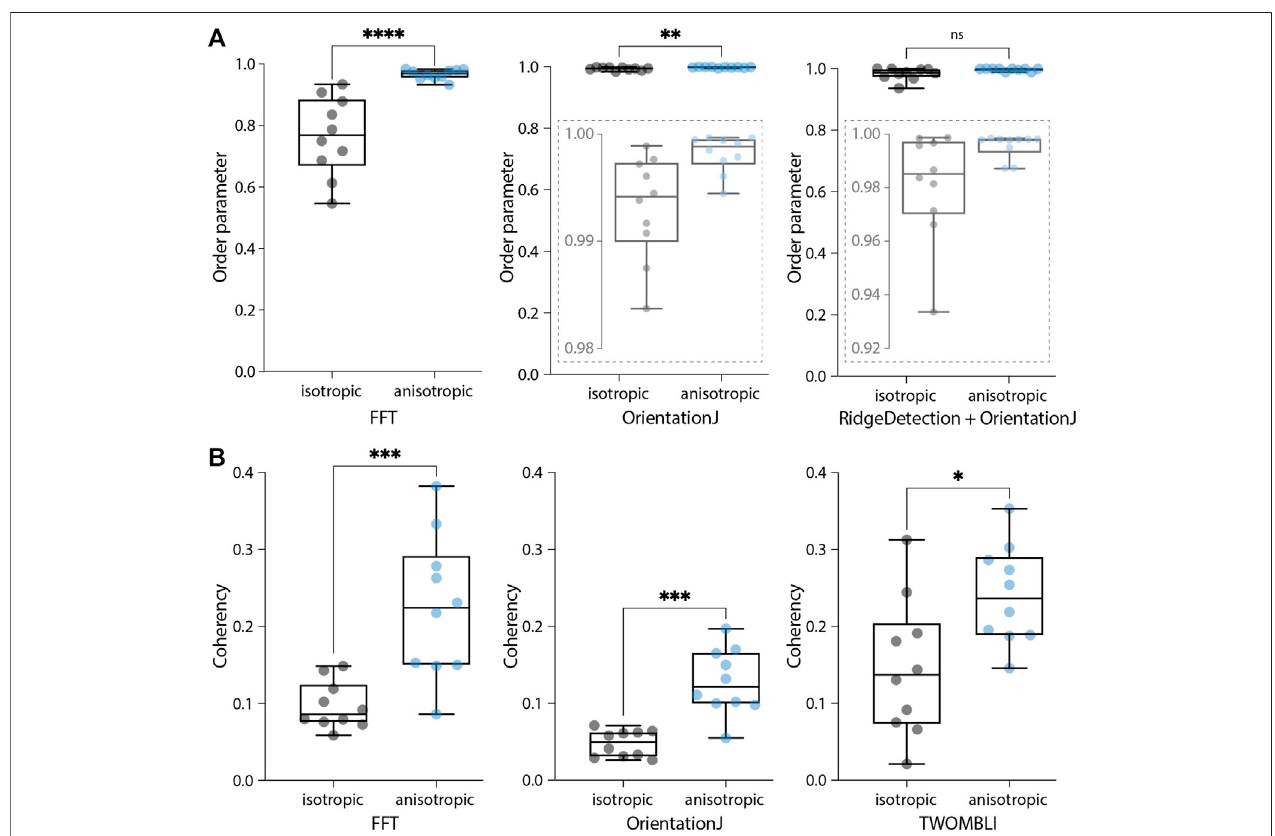
FIGURE10| Comparingoutputmetricsofdifferentapproachestomeasureorganizationinbiologicalimages. (A) Boxplotsoftheorderparametersforthesamples shown in Figure9 calculated withthe three methods, the FFT(as presented here),OrientationJ (Vector Fieldplugin), and thehybrid approach (Ridge Detection followed by OrientationJ Vector Field). Local windows of 100 px with 50 % overlap and 5 x vector neighborhoods were considered. Insets represent zooms of the y-axis to better display distributions. Mann-Whitney two-tailed test (**** p < 0.0001, ** p (cid:1) 0.0039, ns (cid:1) 0.063). (B) Boxplots of the globalcoherency calculated with the three tools, AFT − AlignmentbyFourierTransform (aspresentedhere),OrientationJ (DominantDirectionplugin), andTWOMBLI.Mann-Whitney two-tailedtest (*** p (cid:1) 0.0002,*** p (cid:1) 0.0002, * p (cid:1)